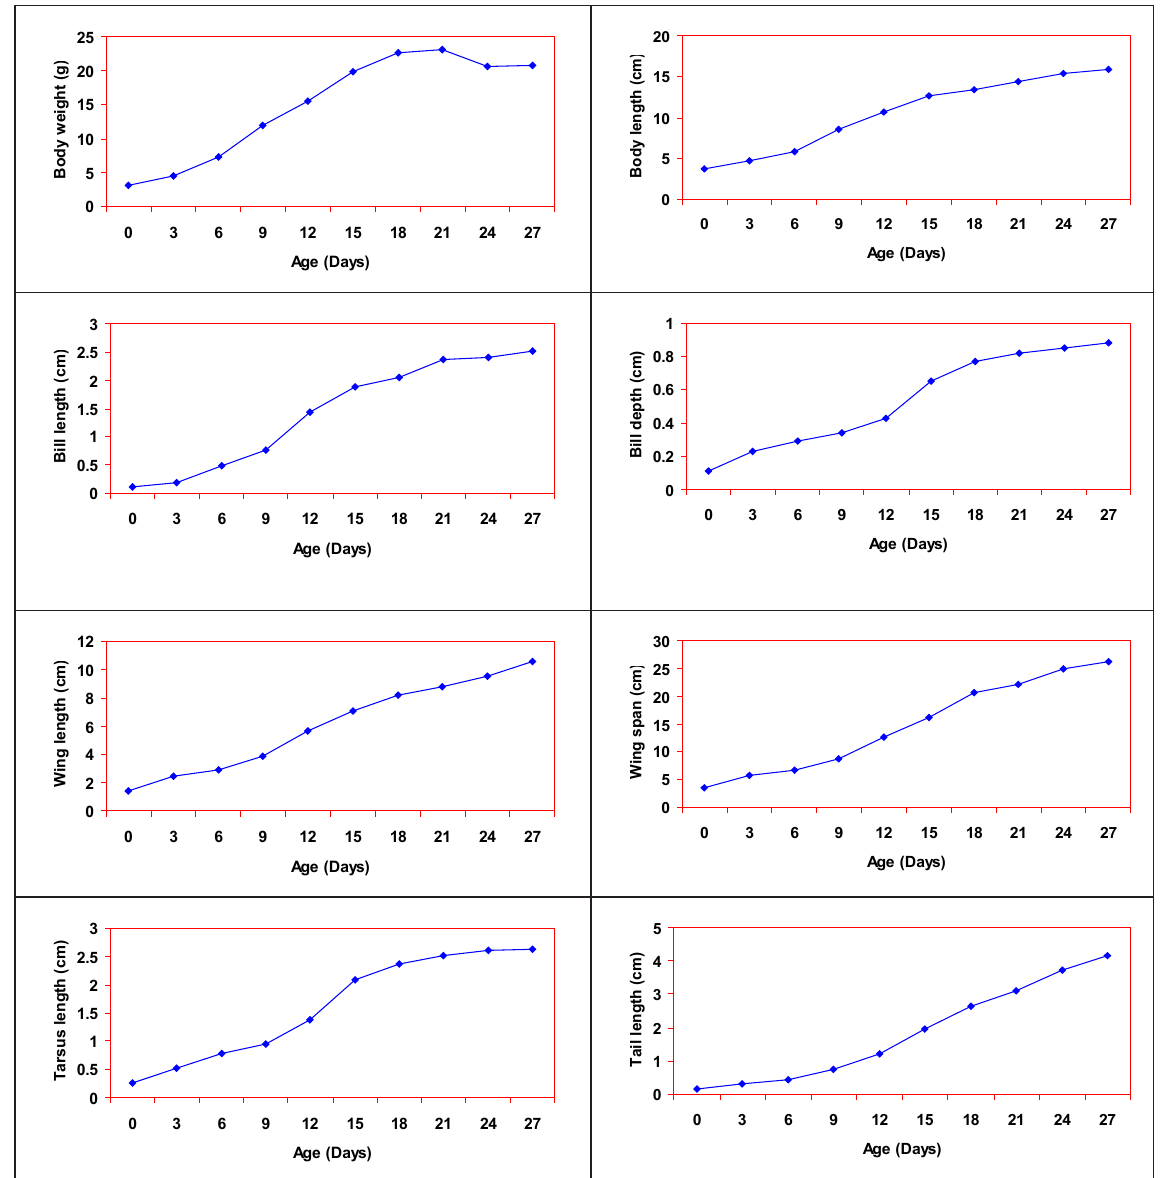
Figure 2. Growth patterns of several body structures of Small Bee-eater